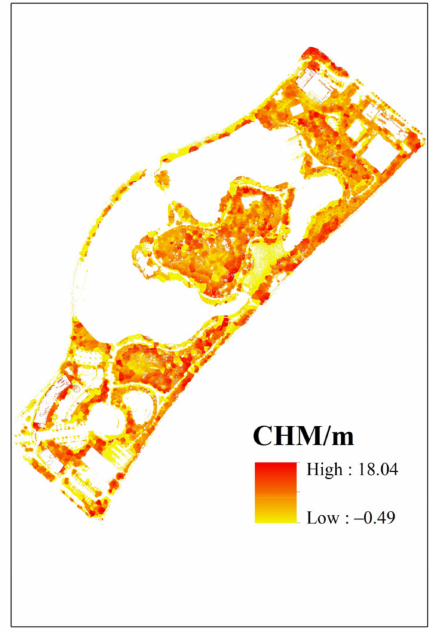
Figure 7. The CHM of the vegetated area.